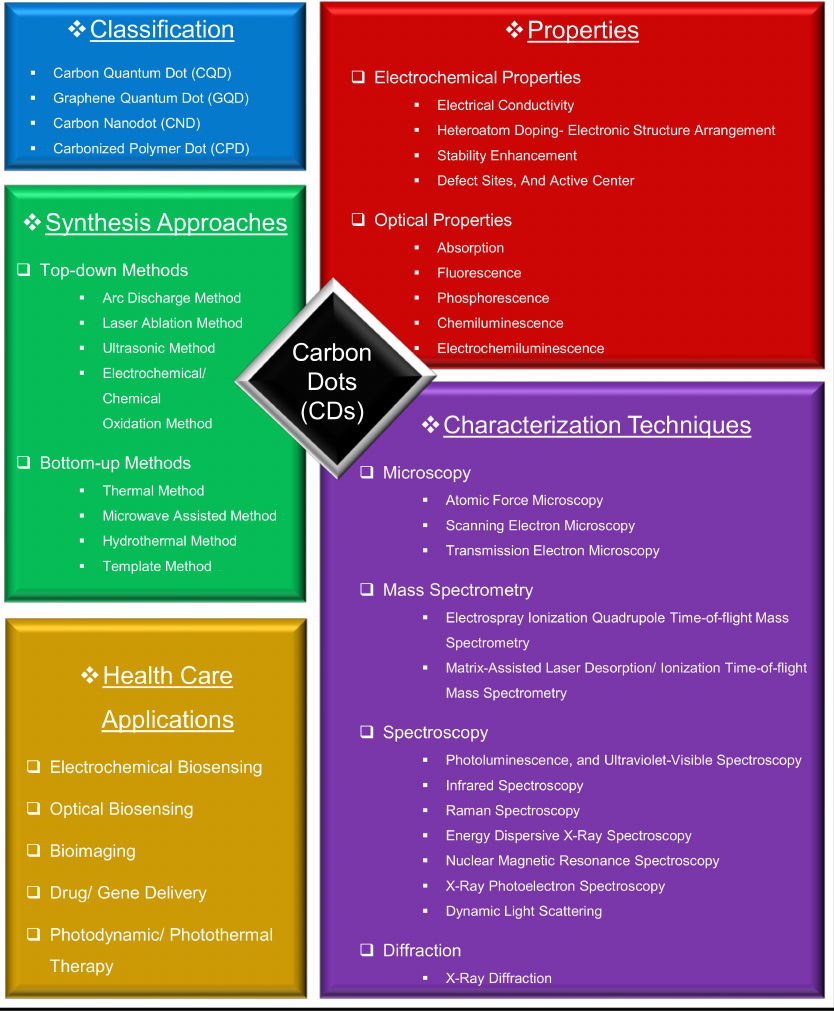
Figure 1. Overview of the classification of CDs, their properties, synthesis approaches, characteriza- tion techniques, and applications in health care.